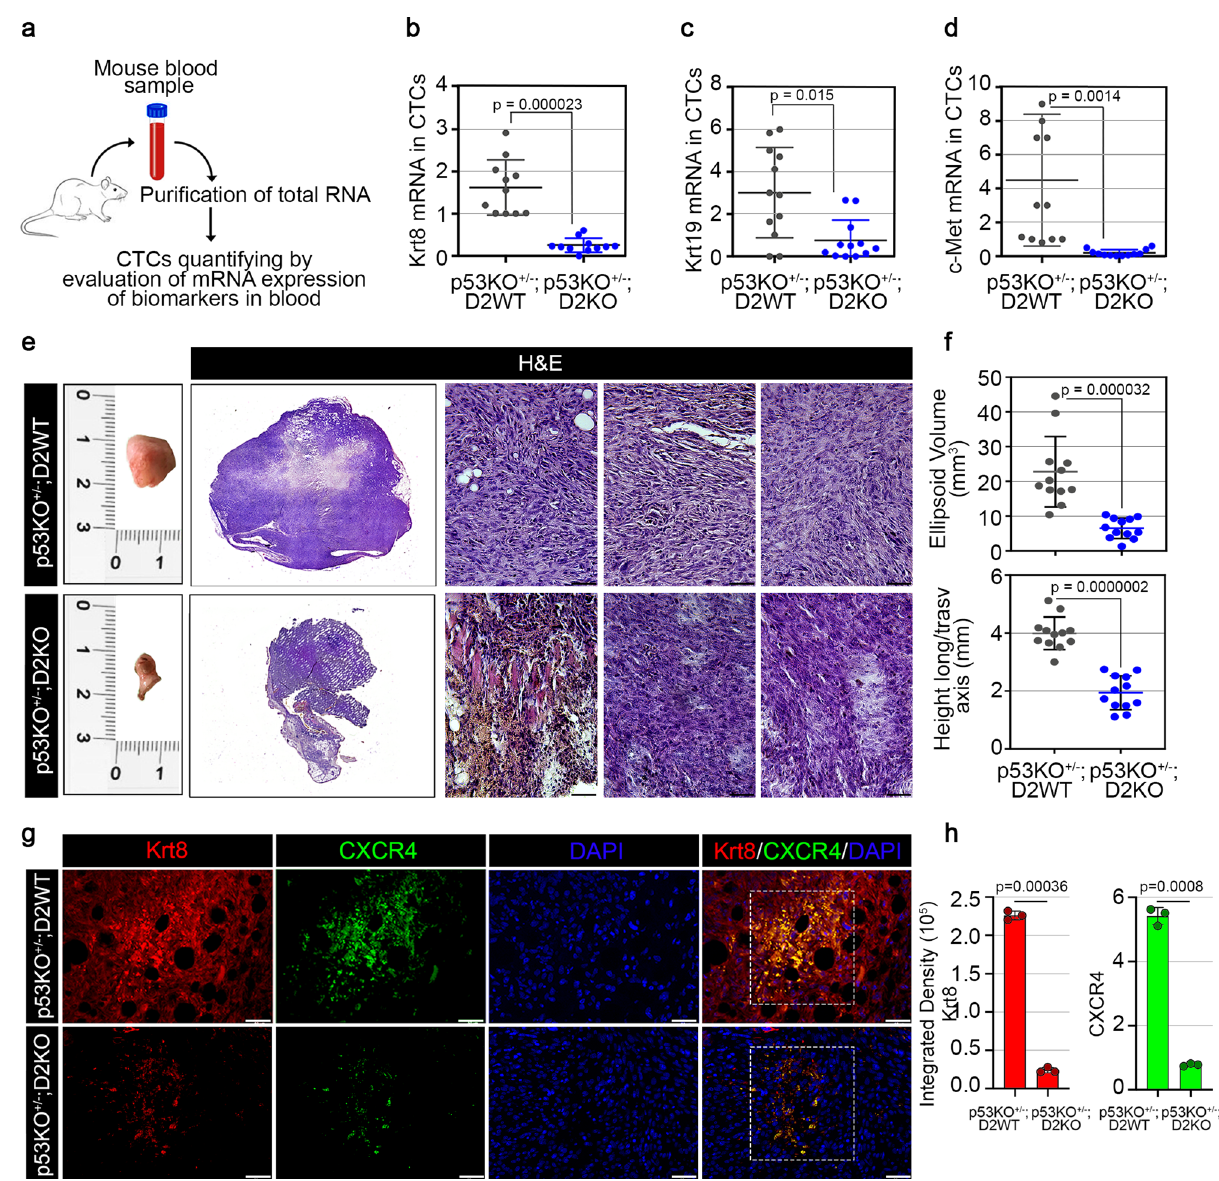
Fig. 4 | Loss of D2 attenuates the p53-dependent tumor metastatization at distant sites. a Graphical representation of the strategy used to isolate circulating tumorcells(CTCs)frommousebloodsamplesofDMBA-treated(i)p53KO +/ − ;D2WT and (ii) p53KO +/ − ;D2KO mice ( n =12 mice/group). b – d mRNA expression of three metastatic biomarkers, Krt8 ( b ), Krt19 ( c ), and c-Met ( d ), was measured by Real- TimePCRinCTCsisolatedfrombloodsamplesofDMBA-treated(i)p53KO +/ − ;D2WT and (ii) p53KO +/ − ;D2KO mice ( n =12 mice/group). e Representative images of inguinallymphnodes from (i) p53KO +/ − ;D2WT and (ii) p53KO +/ − ;D2KO micetreated withDMBAfor8weeksandharvestedat20weeksafter Dio2 geneticdepletionand DMBA administration ( n =12 mice/group). H&E of a representative inguinal lymph node for each group of mice (representative of 3 images per sample, n =3 mice).